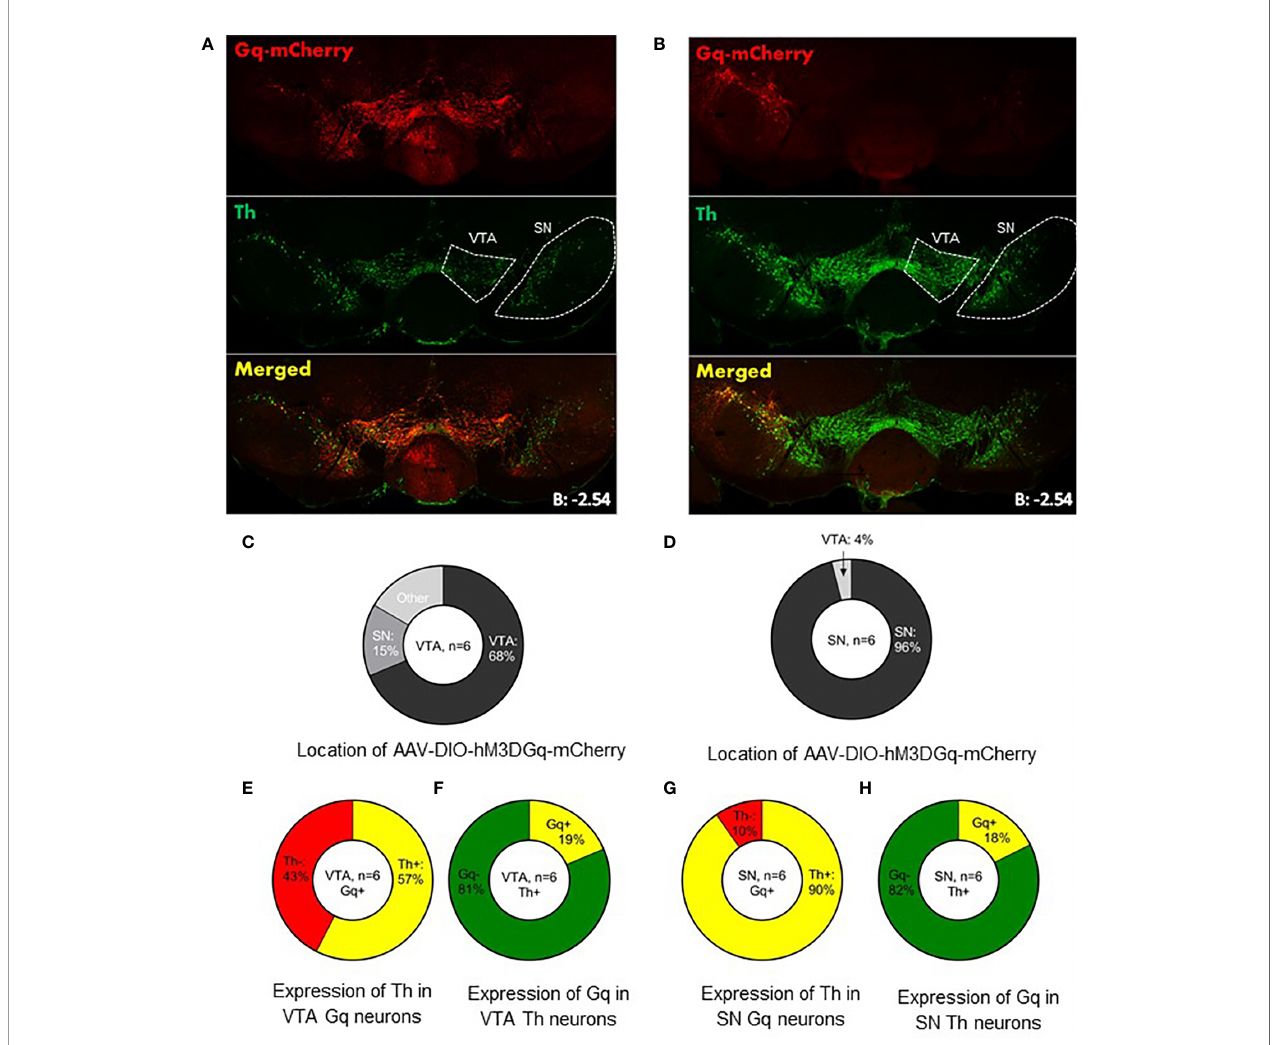
FIGURE 4 | Expression of AAV-DIO-hM3DGq-mCherry in behavioral animals. Representative example of AAV-DIO-hM3DGq-mCherry expression in (A) VTA LepR- Gq mice (n=6) and (B) SN LepR-Gq mice (n=6). (C, D) Analysis of the location of Gq-mCherry expression showed that the majority of Gq-neurons were found in the targeted region. (E) Analysis of Gq and TH in VTA LepR-Gq mice showed that 57% of VTA Gq neurons co-localized with TH-immunoreactivity. (F) 19% of all VTA TH neurons co-localized with Gq. (G) 96% of SN Gq neurons co-localized with TH-immunoreactivity. (H) Of all SN Th neurons, 18% co-localized with